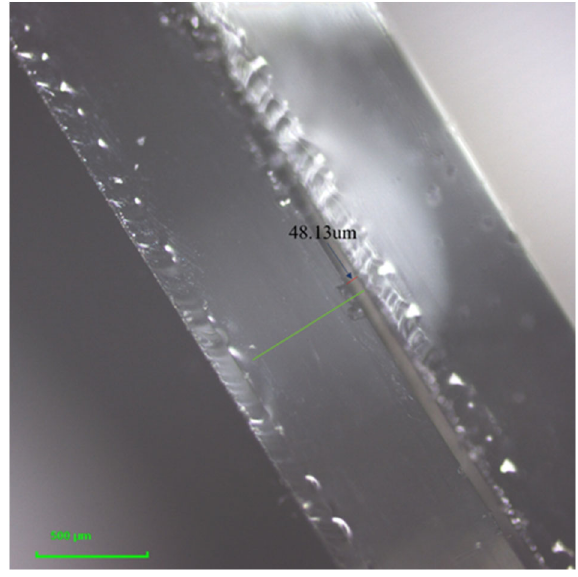
Figure 2. The confocal laser scanning microscope (CLSM) image of the device sample.